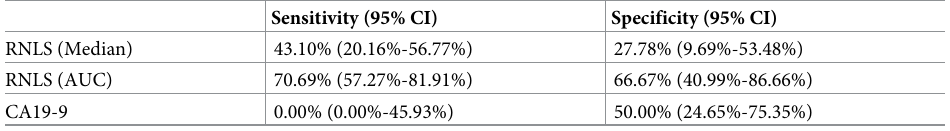
Table 6. Sensitivity and specificity tests of CA19-9 and RNLS levels to predict resection in patients with locally advanced/borderline resectable pancreatic